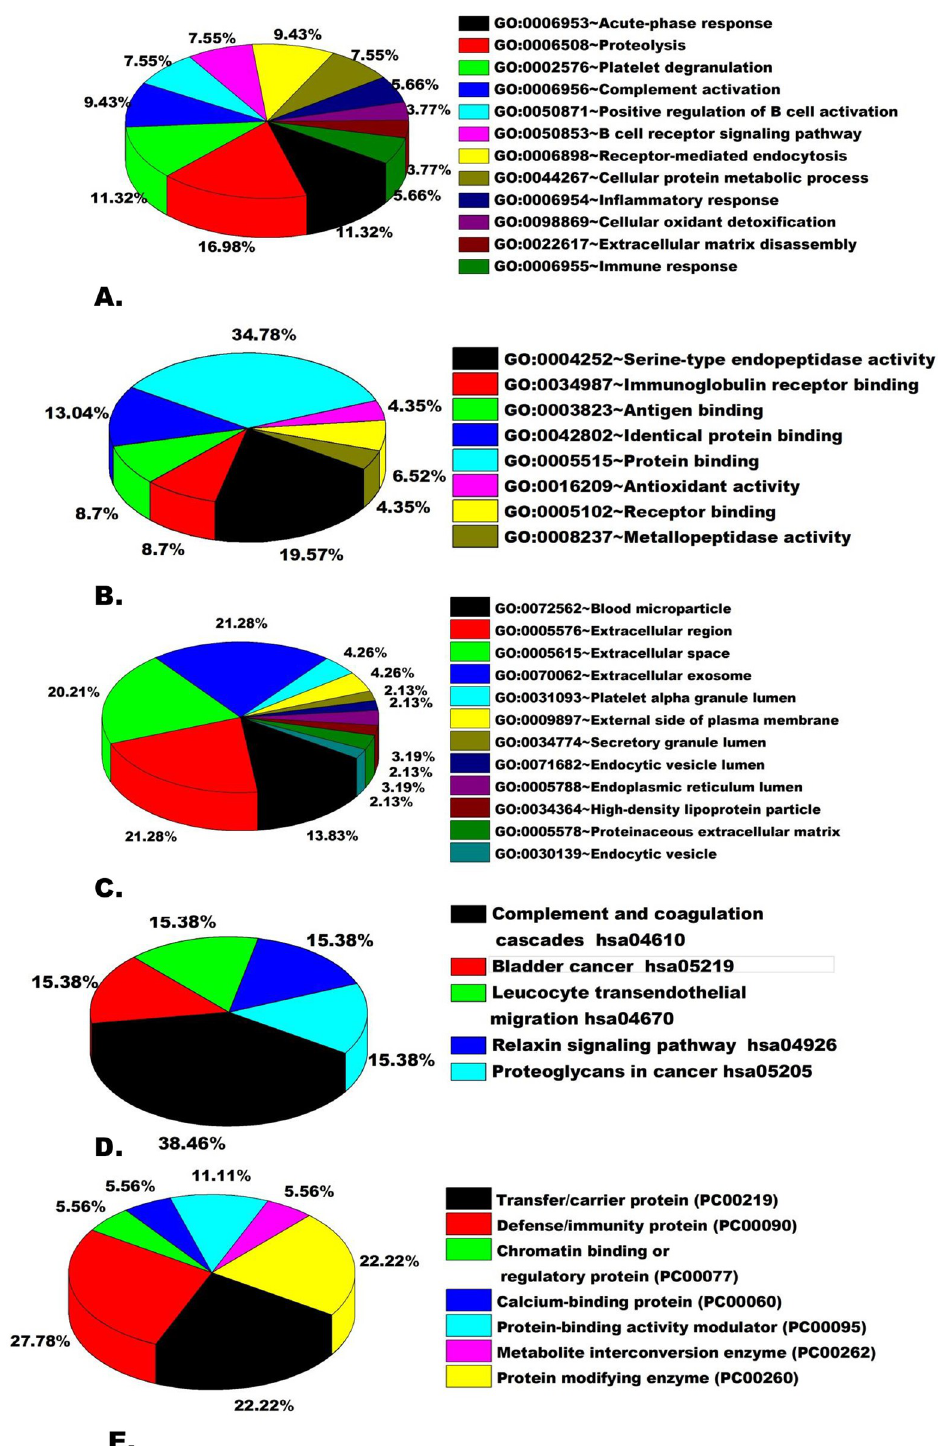
Fig 6. Pie chart depicting the functional classification of differentially expressed proteins in LF patients. Differentially expressed proteins were classified: (A) Biological processes, (B) Molecular functions, (C) Cellular components, (D) KEGG Pathway and (E) Protein